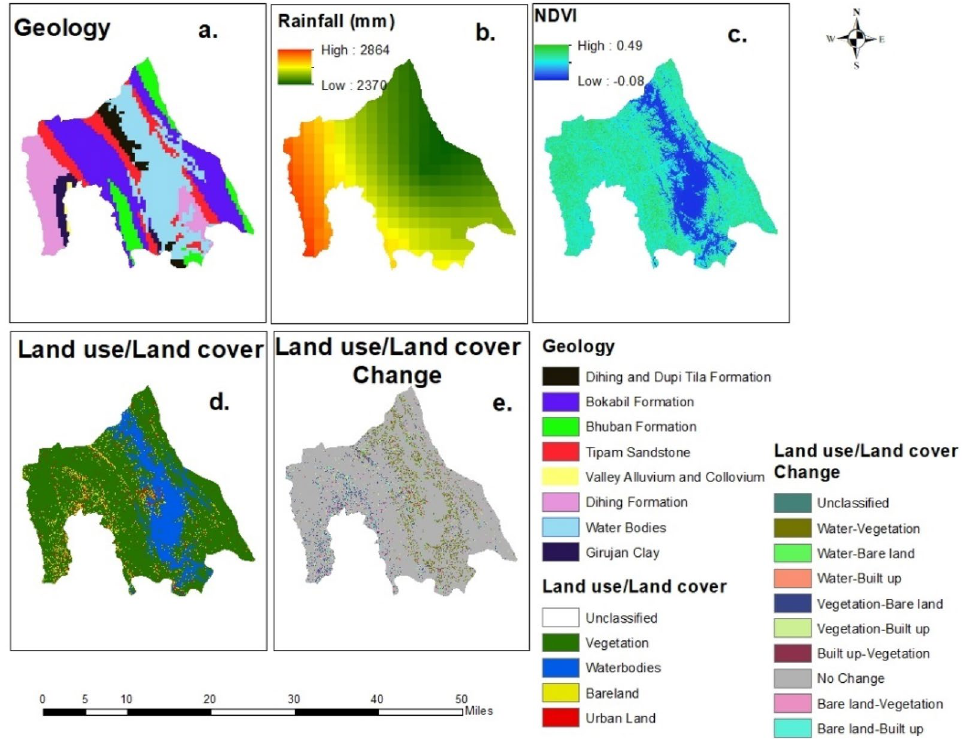
Figure 5. Landslide causal factors: ( a ) Geology; ( b ) Rainfall; ( c ) NDVI; ( d ) Land use/land cover; ( e ) land use/ land cover change (modified from 25 ).